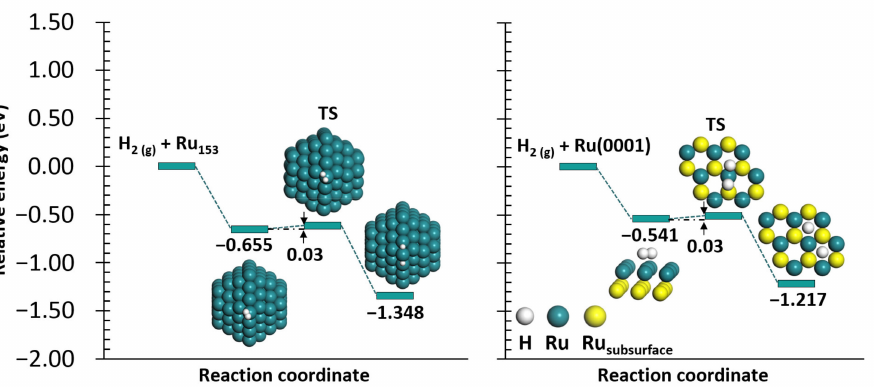
Figure 2. H 2 dissociation on Ru 153 and Ru(0001). Only the surface and subsurface Ru atoms are shown for the H 2 dissociation on Ru(0001). The TS and energy barrier are also